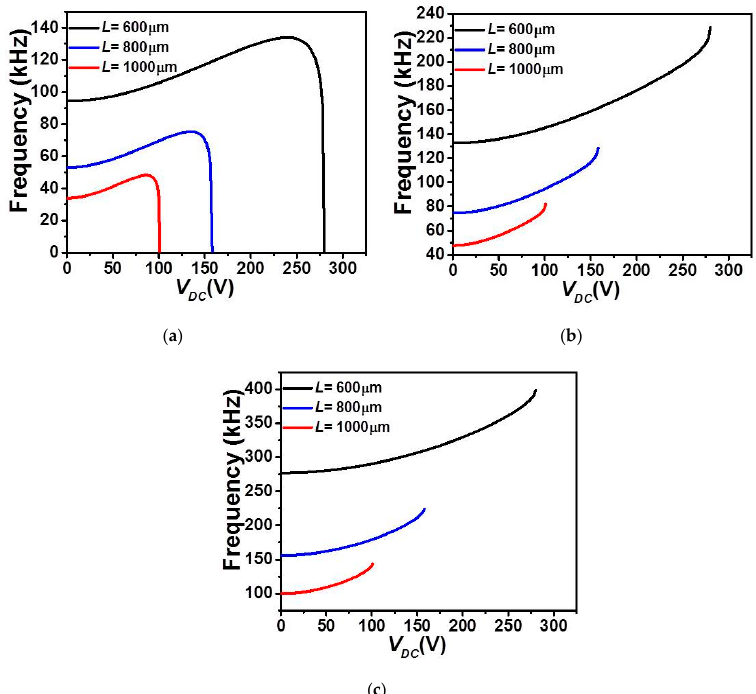
Figure 10. The variation of the ( a ) first, ( b ) second, and ( c ) third in-plane flexure natural frequencies for Case 2 as varying V DC with uniform g and for various values of L.